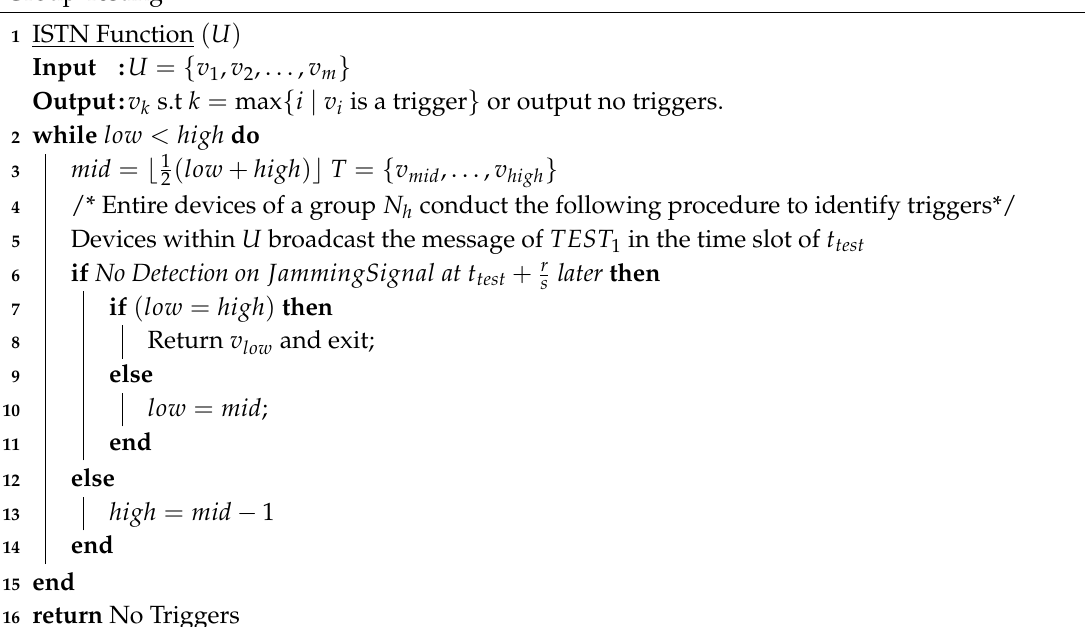
Algorithm 3: Identification of A Single Trigger Node Algorithm ISTN based on Sequential Group